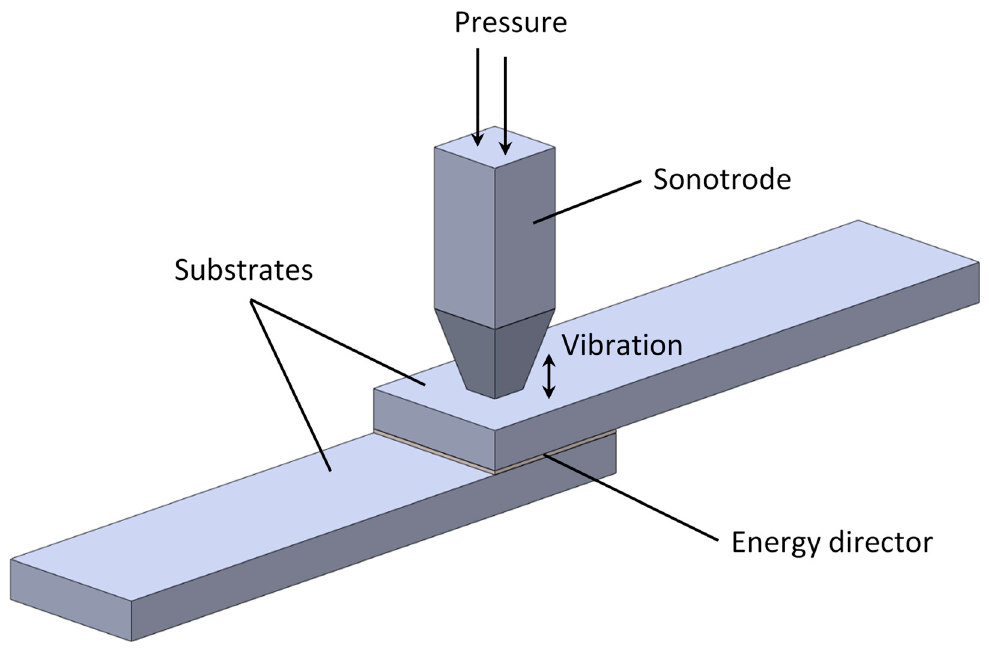
Figure 8. Schematic representation of ultrasonic welding process. Table 2. Process parameters and its typical values of resistance welding (RW), induction welding (IW), and ultrasonic welding (UW).